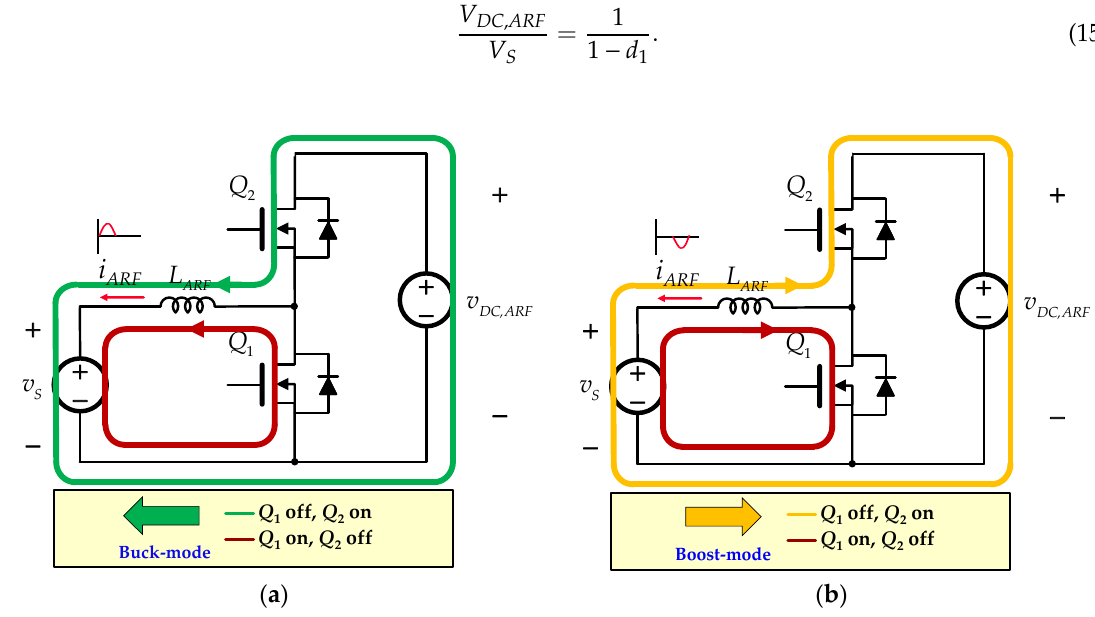
Figure 5. Circuit architecture of the ARF [26]: ( a ) the buck mode and ( b ) the boost mode.